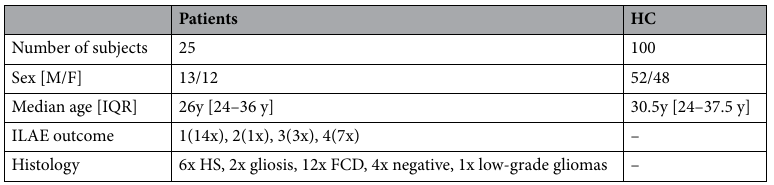
Table 1. Demographic and clinical summary of study group and control subjects. M male, F female, IQR interquartile range (Q1–Q3), HS hippocampal sclerosis, FCD focal cortical dysplasia, HC healthy